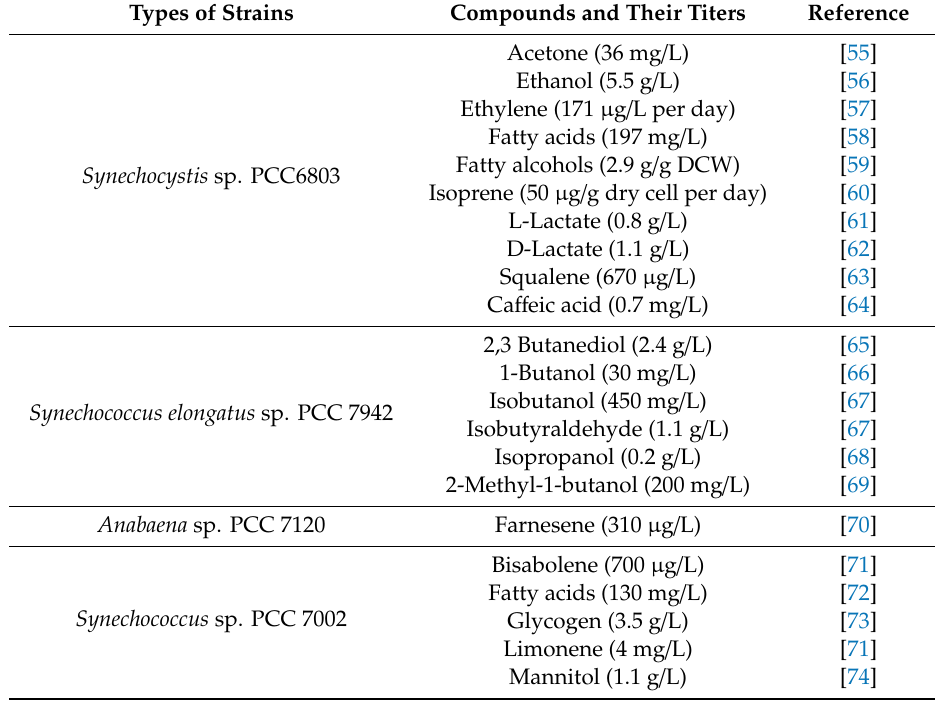
Table 1. Potentials of cyanobacterial strains to produce biofuel and other compounds using metabolic and genetic engineering